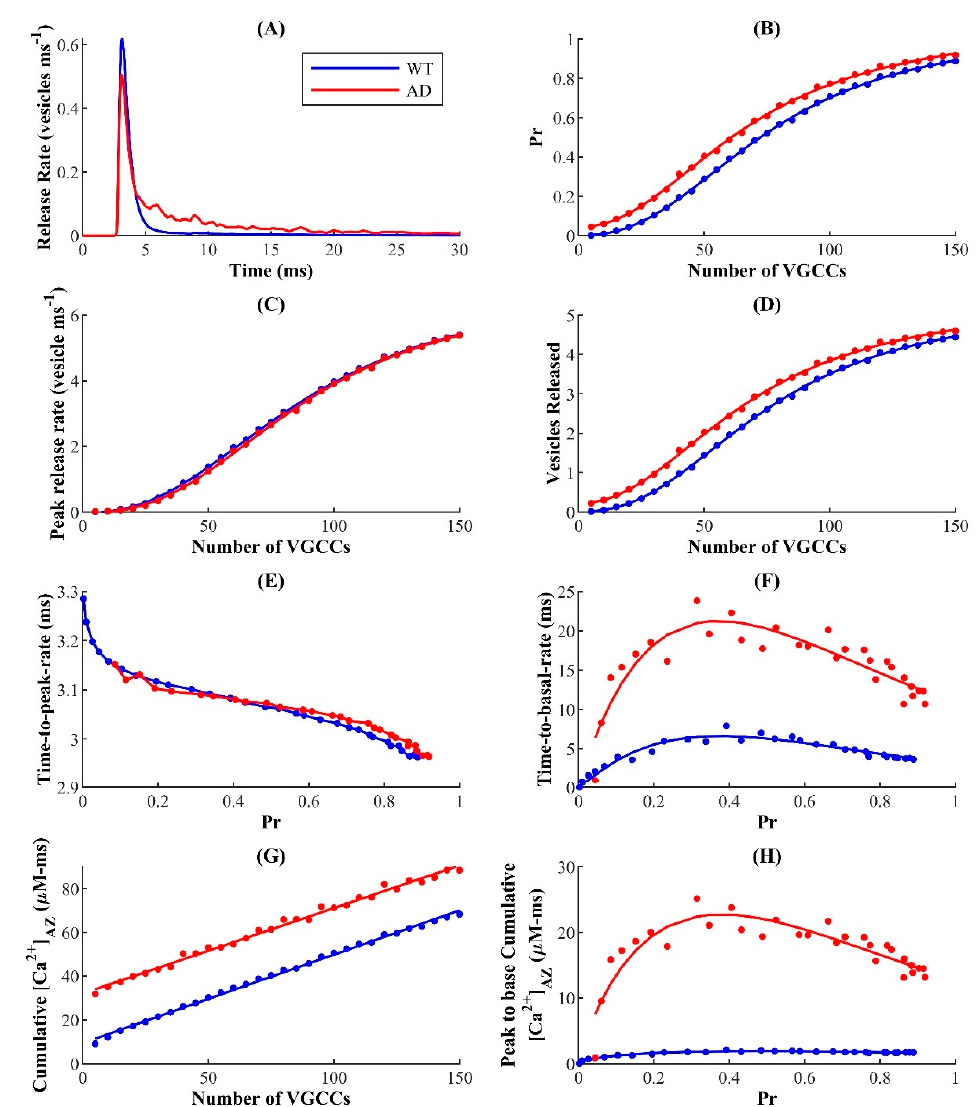
Figure 5. ER-driven upregulation of cytosolic Ca 2+ leads to enhanced synaptic vesicle release in FAD: ( A ) Neurotransmitter release rate in response to a single AP in WT and AD − affected synapse. Change in the P r of a single synaptic vesicle ( B ); peak release rate ( C ); and the average number of vesicles released ( D ) as functions of the number of VGCCs; ( E ) Time delay of peak release rate and ( F ) decay time to basal release rate as functions of P r ; ( G ) Change in [𝐶𝑎 (cid:3002)(cid:3027)(cid:2870)(cid:2878) ] with number of VGCCs; ( H ) Cumulative Ca 2+ from peak to basal level as a function of P r .